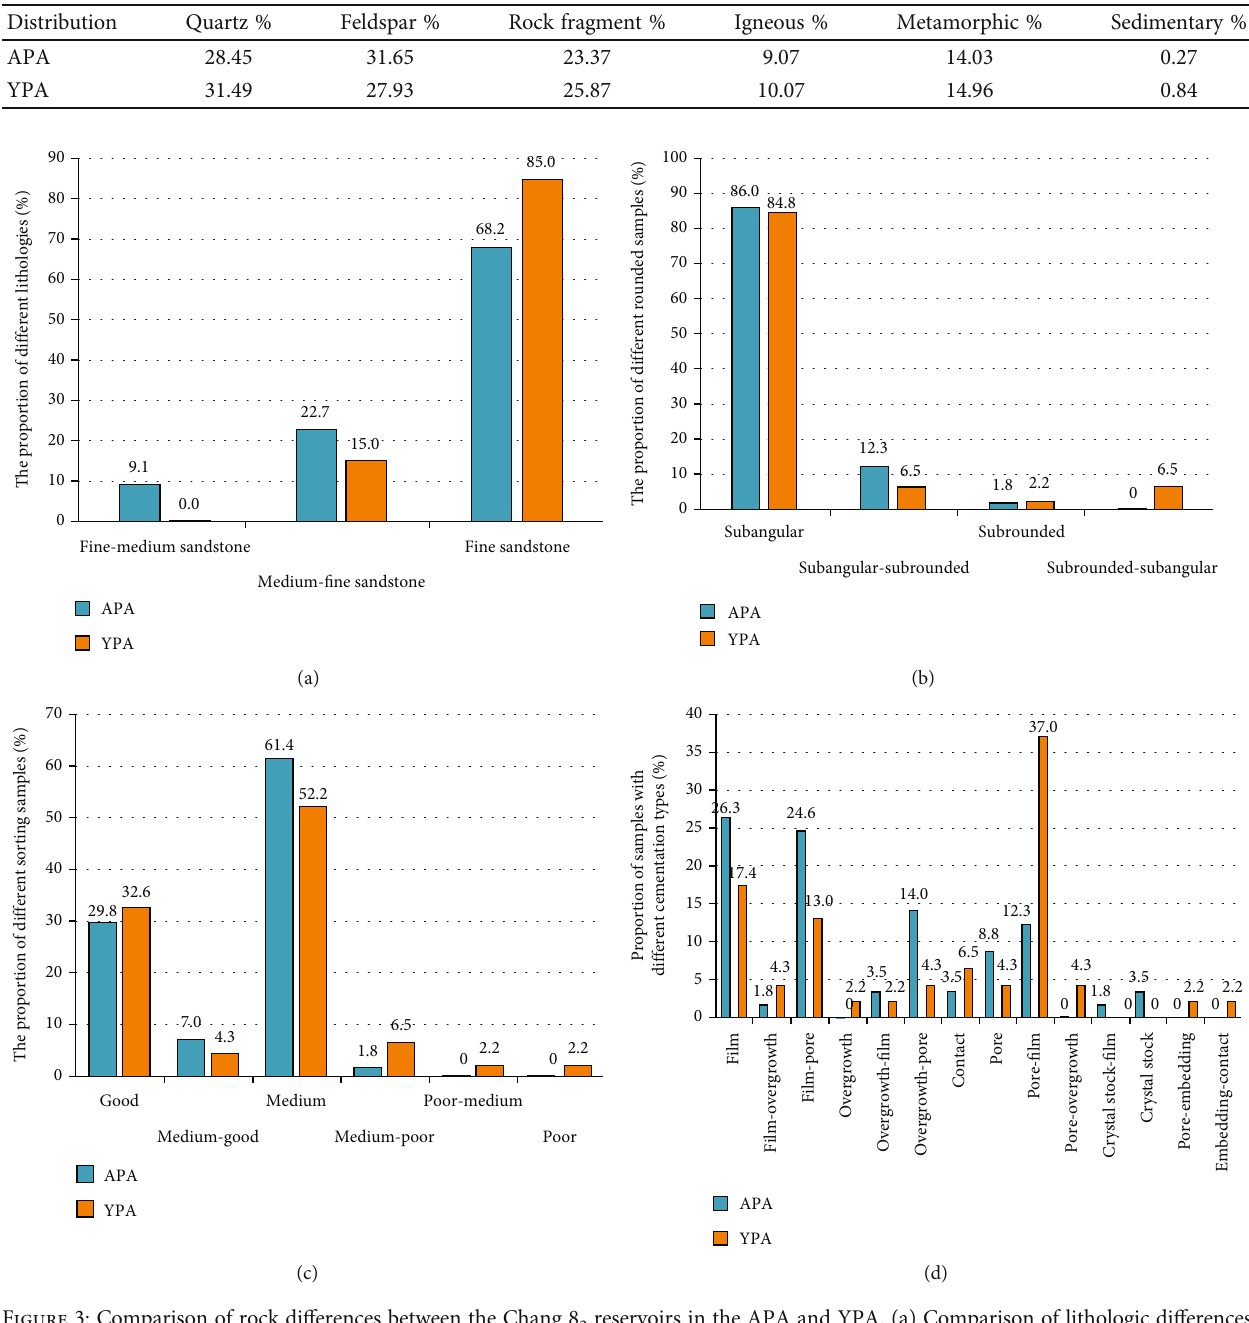
reservoir in the YPA and APA in the Jiyuan area. 2